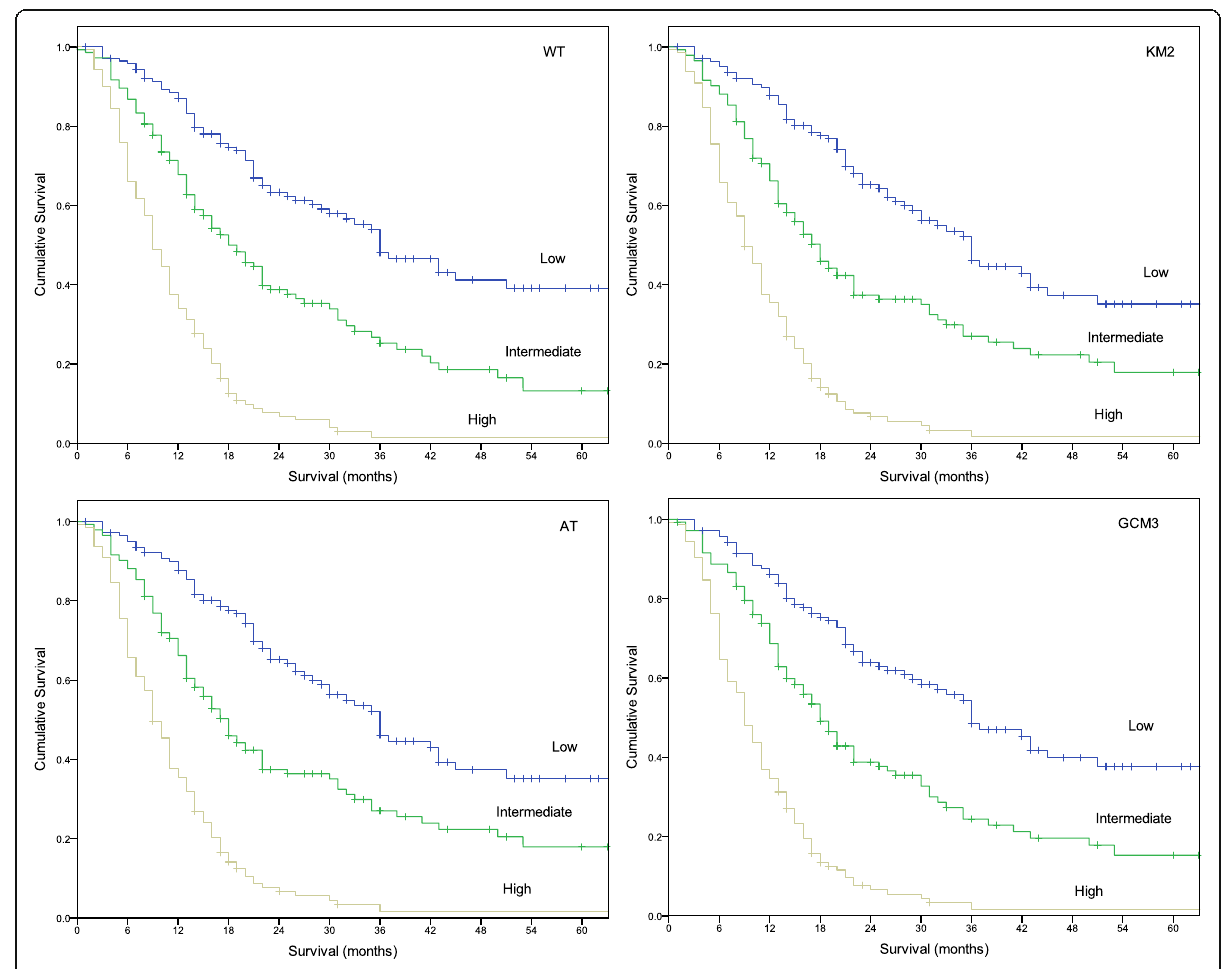
Fig. 1 Risk stratification and OS for WT (top left), KM2 (top right), AT (bottom left) GCM3 (bottom right)